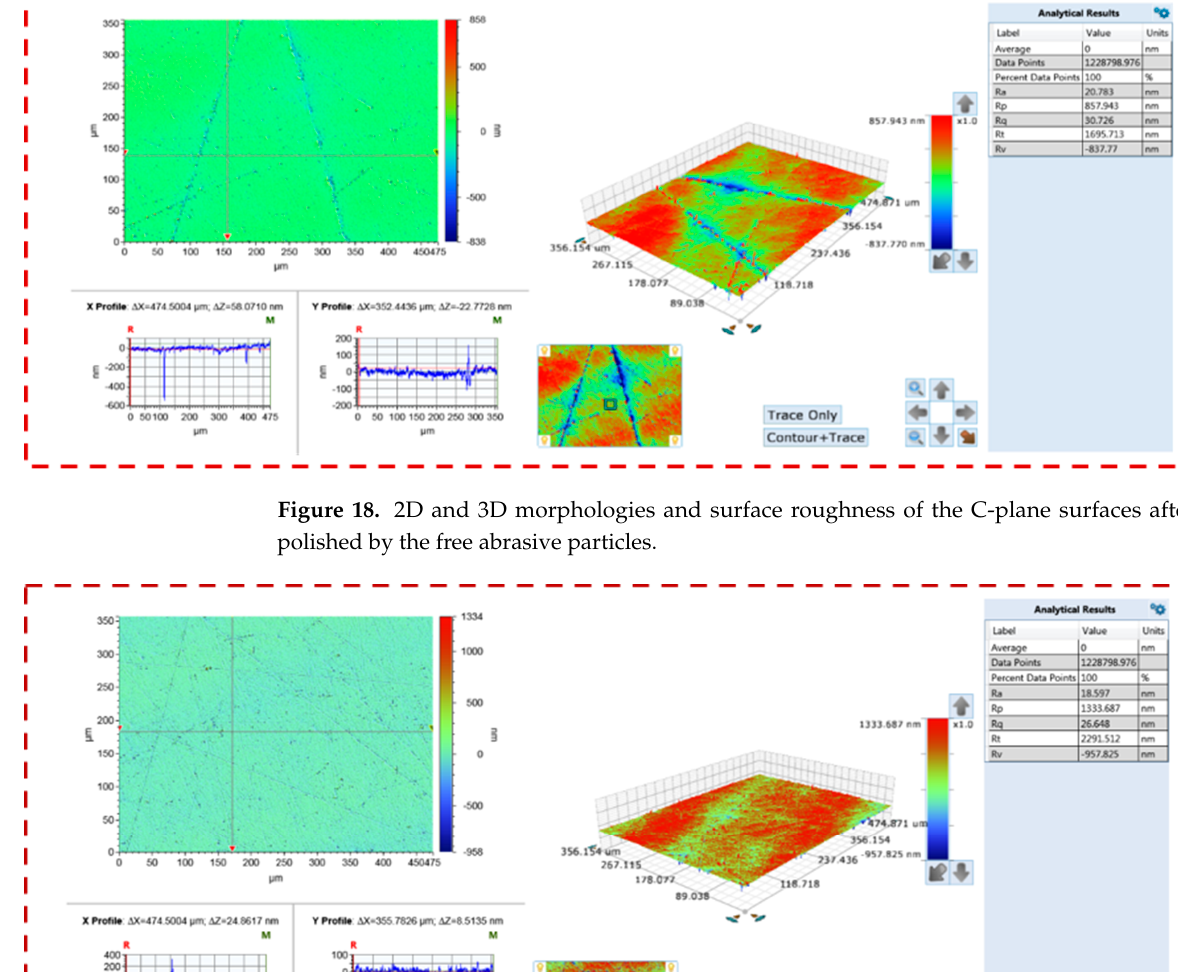
Figure 17. The polishing effect of the abrasive particles’ size on both sides of the C and Si planes. ( a ) Surface roughness of the C surface. ( b ) Surface roughness of the Si surface.